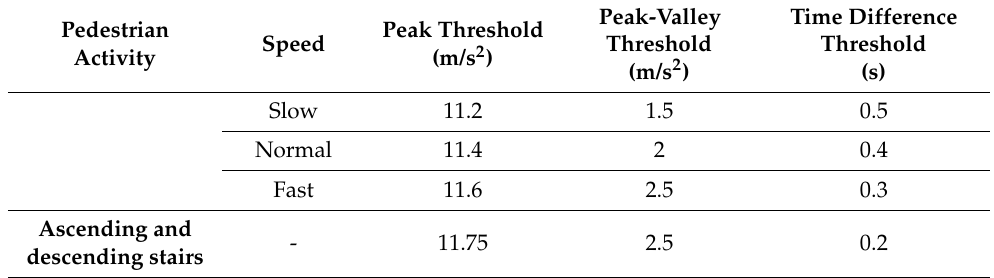
Table 6. Threshold values.